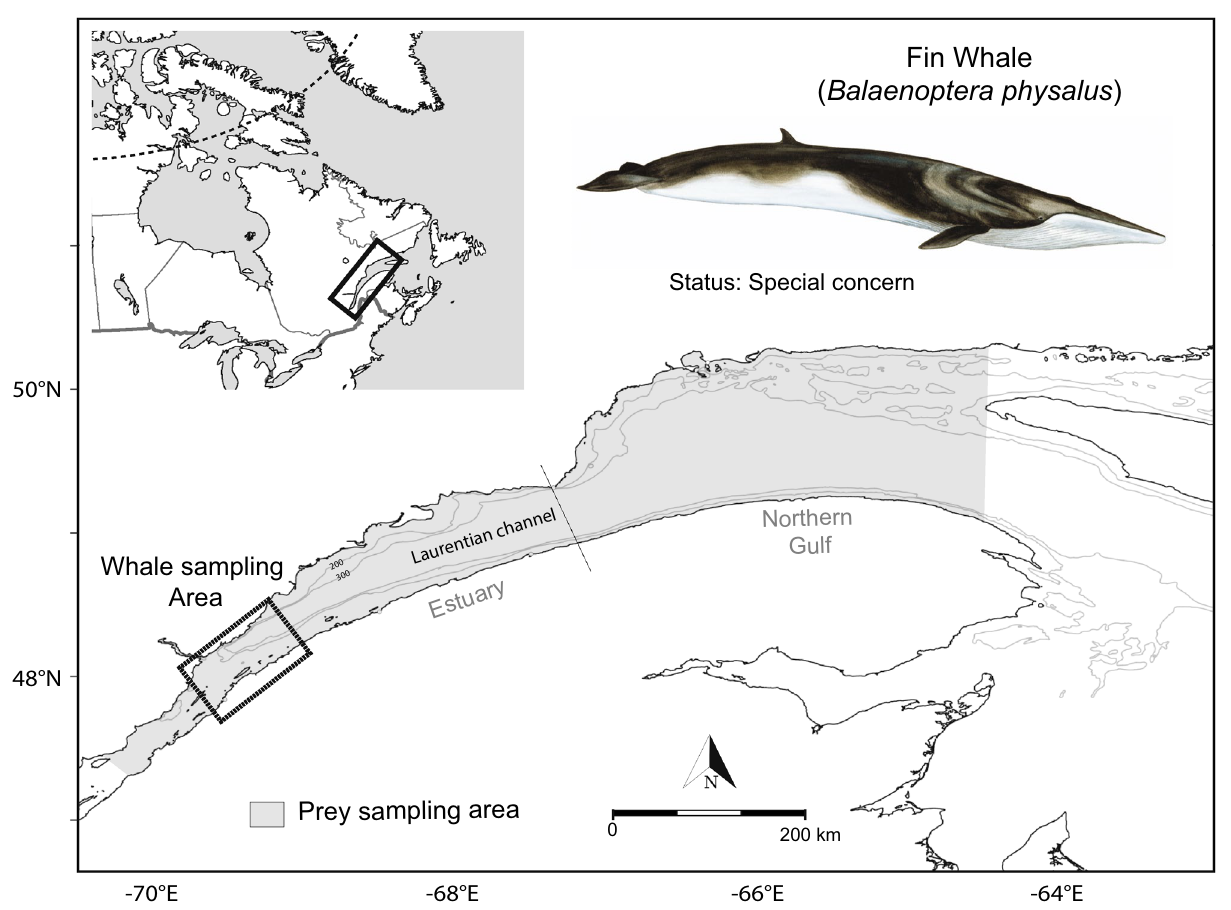
Figure 6. Sampling area where fin whales (black square) and potential prey (shade area) were sampled between 1998 and 2006. The dashed line indicates the boundary between the Estuary and Gulf of St. Lawrence. Map was produced by the authors with R (v3.6.2, https:// www.r- proje ct. org/) using a bathymetry data provided by the Canadian Hydrographic Service. Fin whale drawing was kindly provided by R.